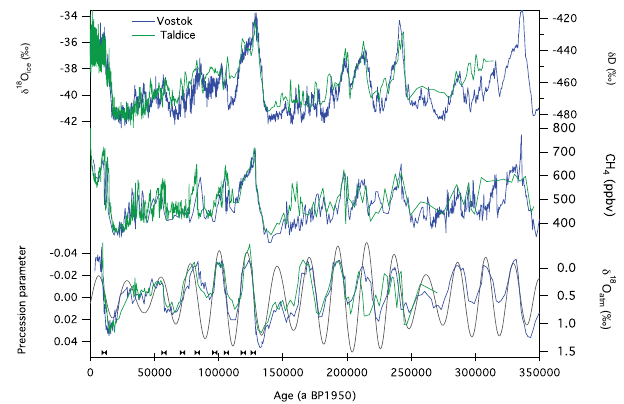
Fig. 3. Comparison between Vostok (blue) and TALDICE (green) ice cores on the δ 18 O atm chronology (Bender, 2002) and TALDICE 1a age scale (Buiron et al., 2011; Sch¨upbach et al., 2011), respec- tively. Top: water stable isotope records ( δ D and δ 18 O ice , respec- tively) (Petit et al., 1999; Stenni et al., 2011). Middle: methane records, Vostok: Petit et al. (1999); Caillon et al. (2003); Delmotte et al. (2004), TALDICE: Buiron et al. (2011); Sch¨upbach et al. (2011). Bottom: δ 18 O atm records: Vostok: Bender (2002); Suwa and Bender (2008), TALDICE: Buiron et al. (2011) and this study. The grey curve corresponds to the precession parameter. Black markers indicate the position of stratigraphic links between TALDICE and Vostok deduced from δ 18 O atm data.